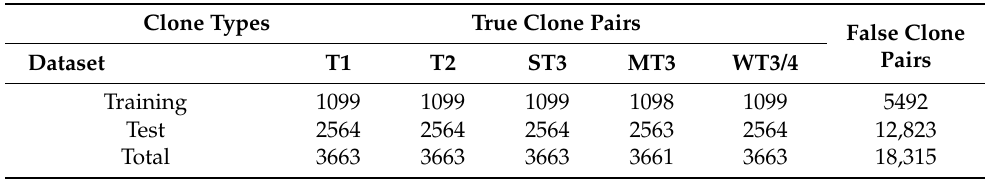
Table 2. Training and test dataset used.